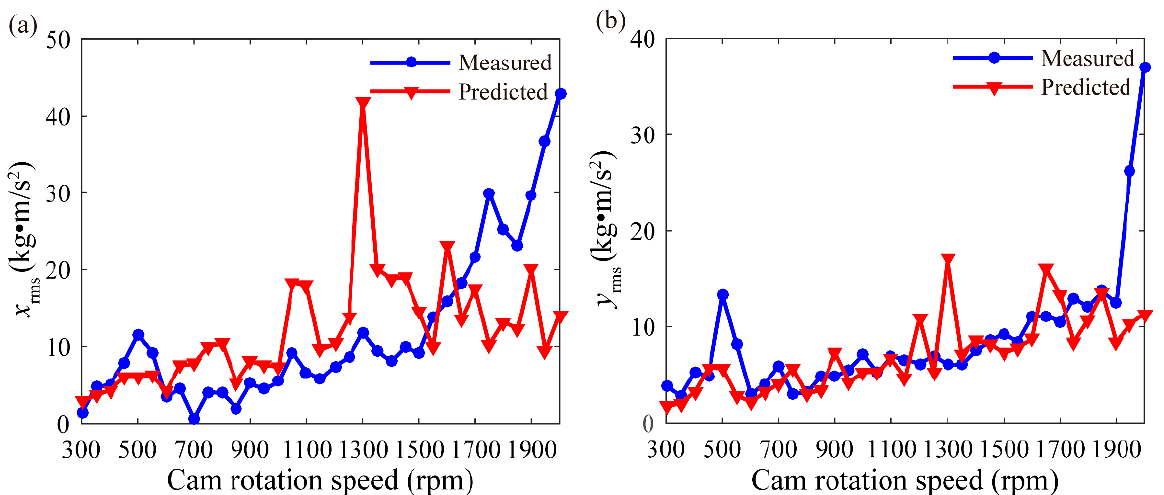
Figure 4. Comparison of the measured and predicted vibration at cam speed of 300–2000 rpm: ( a ) direction x and ( b ) direction y.